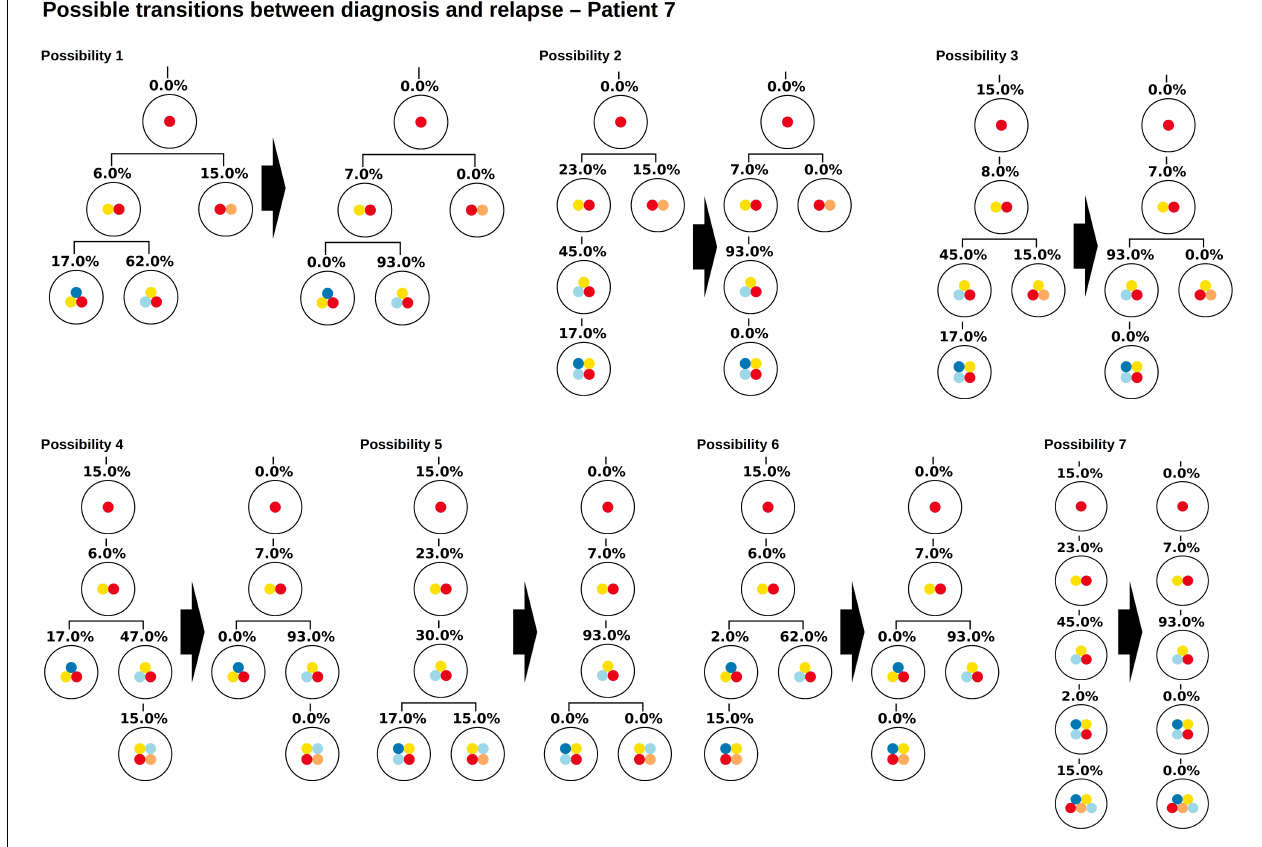
FIGURE 7 | Example of a patient with multiple founder clones. In this figure the root corresponds to wild type cells. The two founding events are indicated by yellow and orange circles. The Figure shows all hierarchies that are compatible with VAFs at diagnosis and relapse. Possibility 1 coincides with the hierarchy obtained from single cell sequencing.